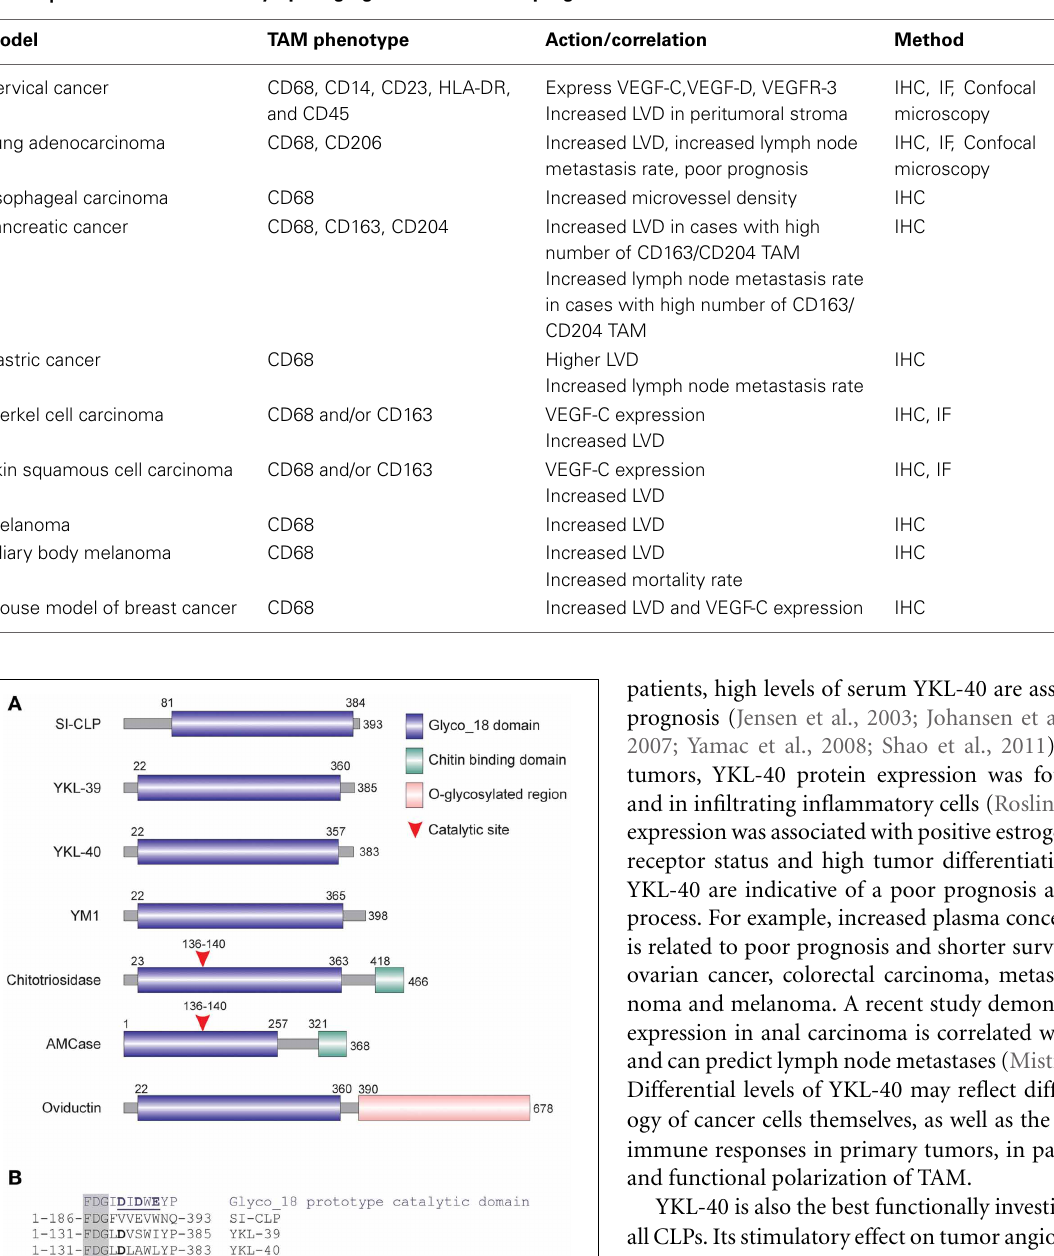
Table 1 | Role of TAM in tumor lymphangiogenesis and tumor progression.